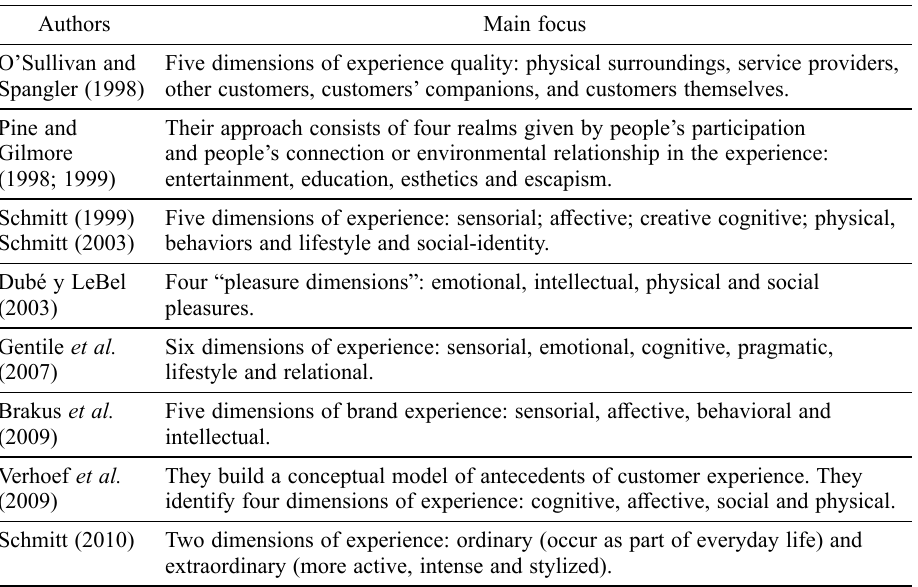
Table 1. Customer experience